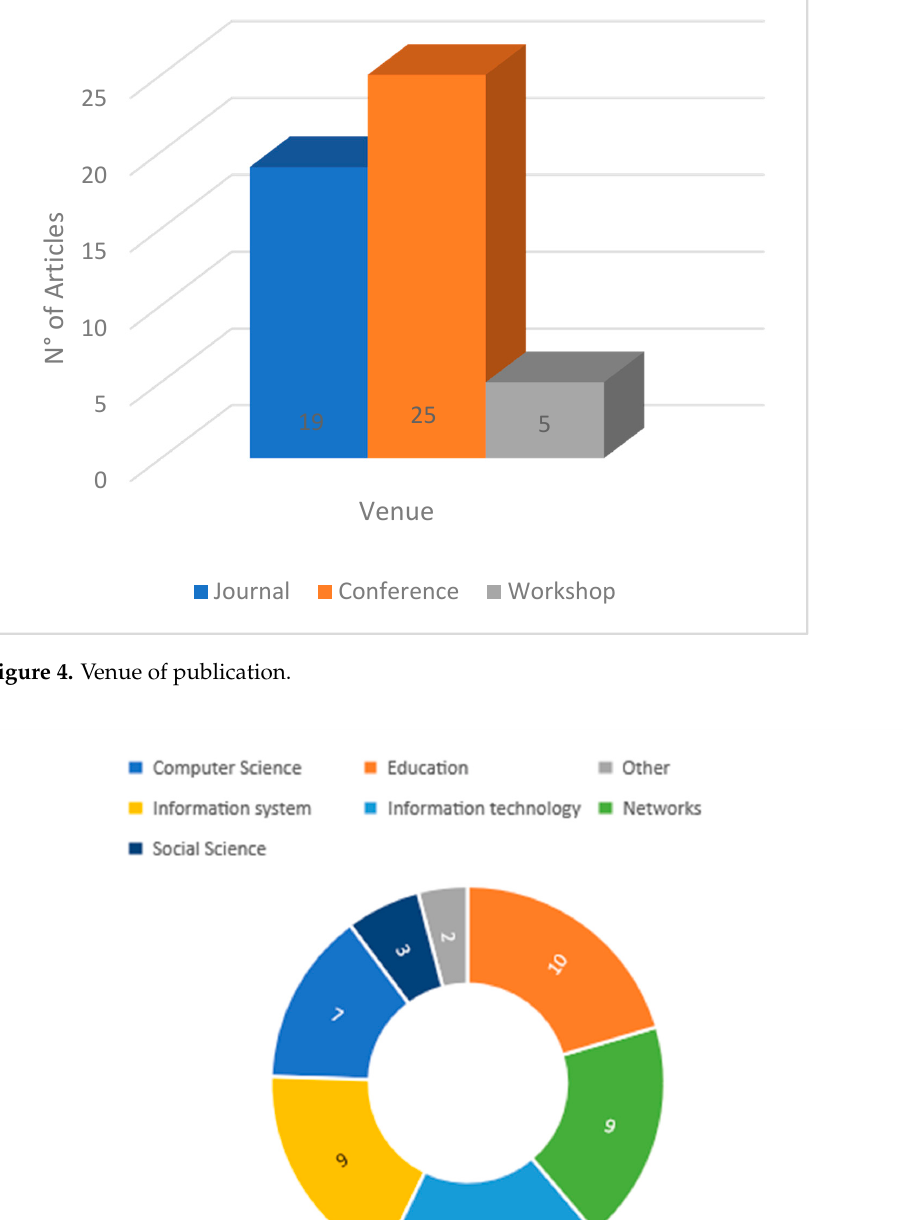
Figure 5. Subject distribution.